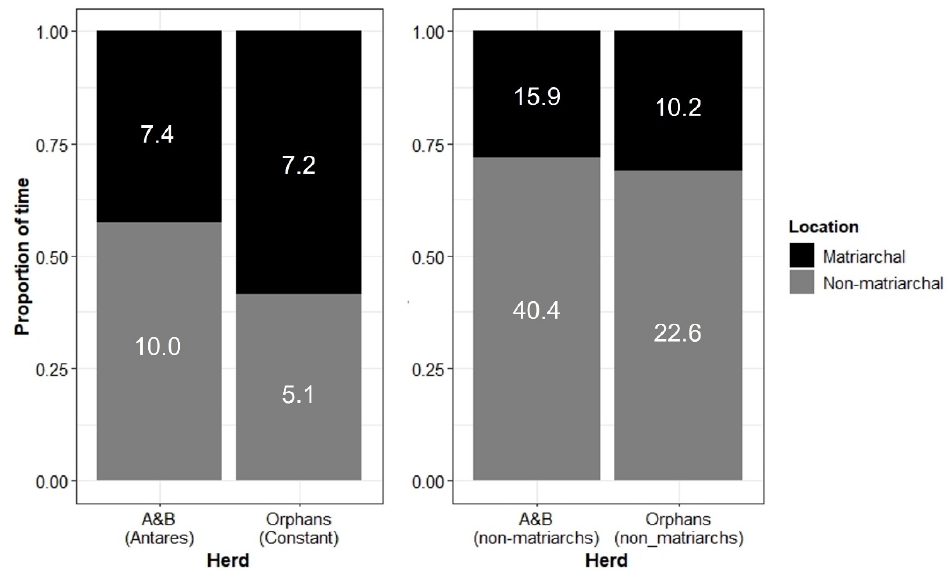
Figure 10. ( Left ): The position of matriarchs Antares (A&B herd) and Constant (Orphans) in relation to the herd. ( Right ): The position of non-matriarch adult females in relation to the herd. “Matriarchal” positions include following, leading (matriarchs)/or moving at the front (non-matriarchs), or moving on the outer edge of the herd. “Non-matriarchal” positions include moving within the herd, following at the rear/trailing the herd, or not with the herd (see Supplementary Materials for full ethogram). Numbers within bars show the number of focal hours contributing to each category.